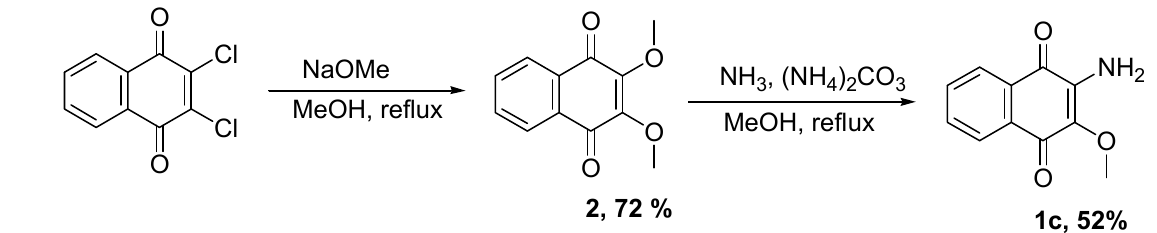
Scheme 2. Synthesis of 2-amino-3-methoxy-1,4-naphthoquinone.